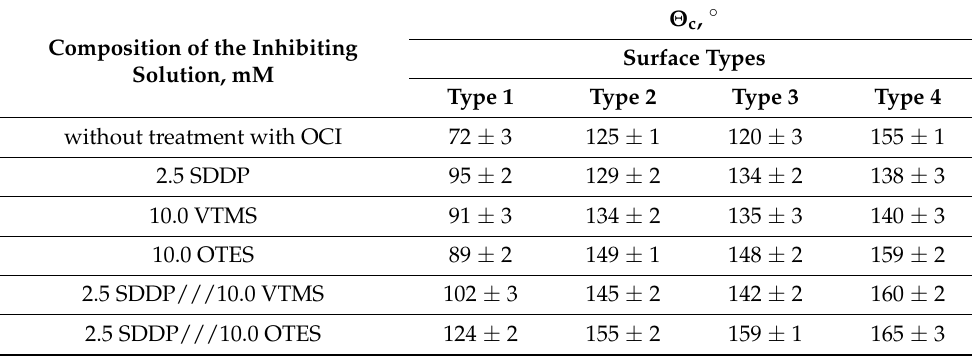
Table 3. Θ c values on “smooth” (Type 1) and textured (Types 2–4) zinc surfaces without and with treatment in SDDP and TASs